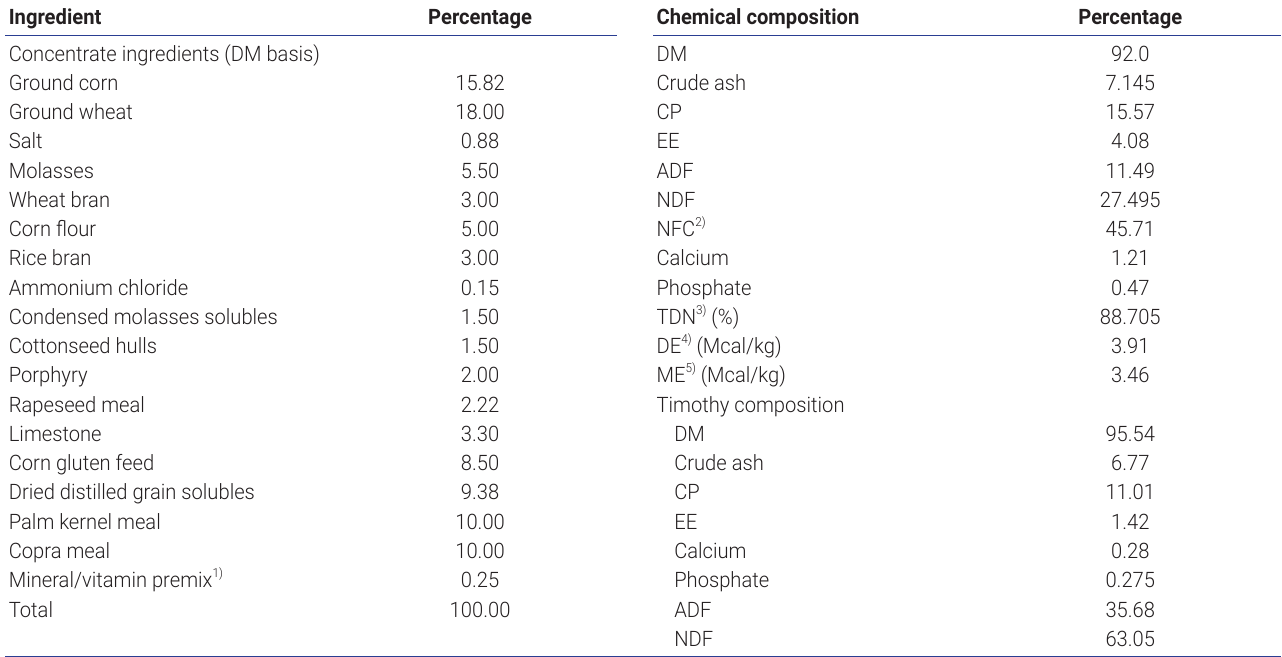
Table 1. Ingredients and chemical composition of experimental